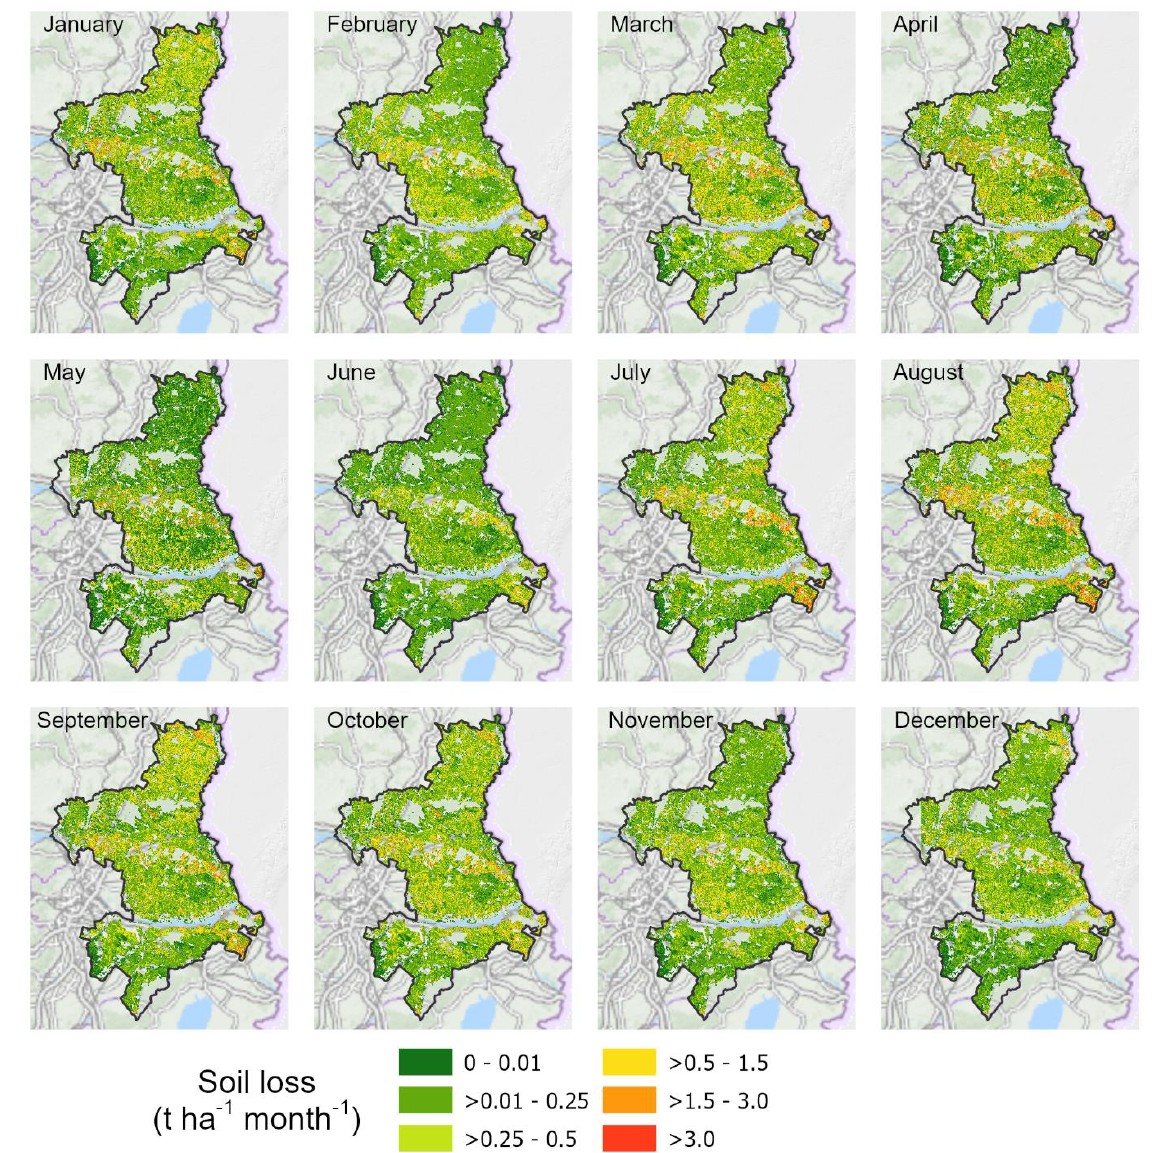
Figure 7. Monthly soil loss (t ha −1 month −1 ) modeled by revised wind erosion equation for the study region in eastern Austria. Table 4. Statistical parameters of the modeled monthly soil loss in t ha −1 month −1 by the revised wind erosion equation. Modeled Soil Loss in t ha −1 month −1 Month